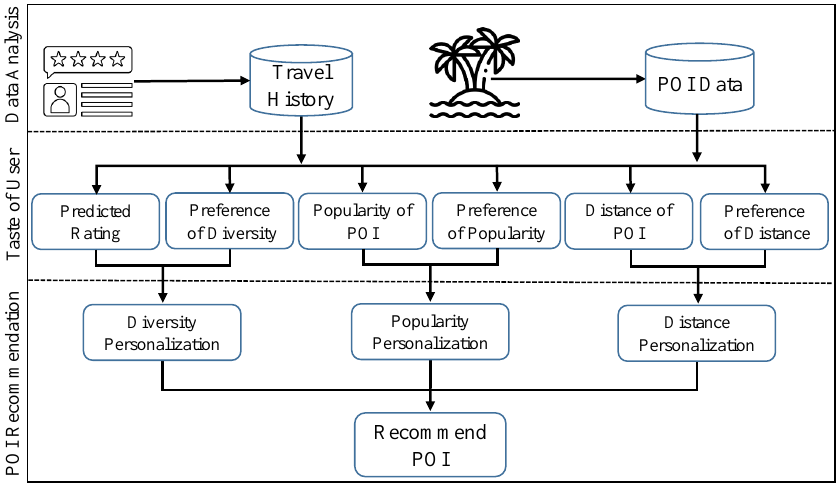
Figure 1. System